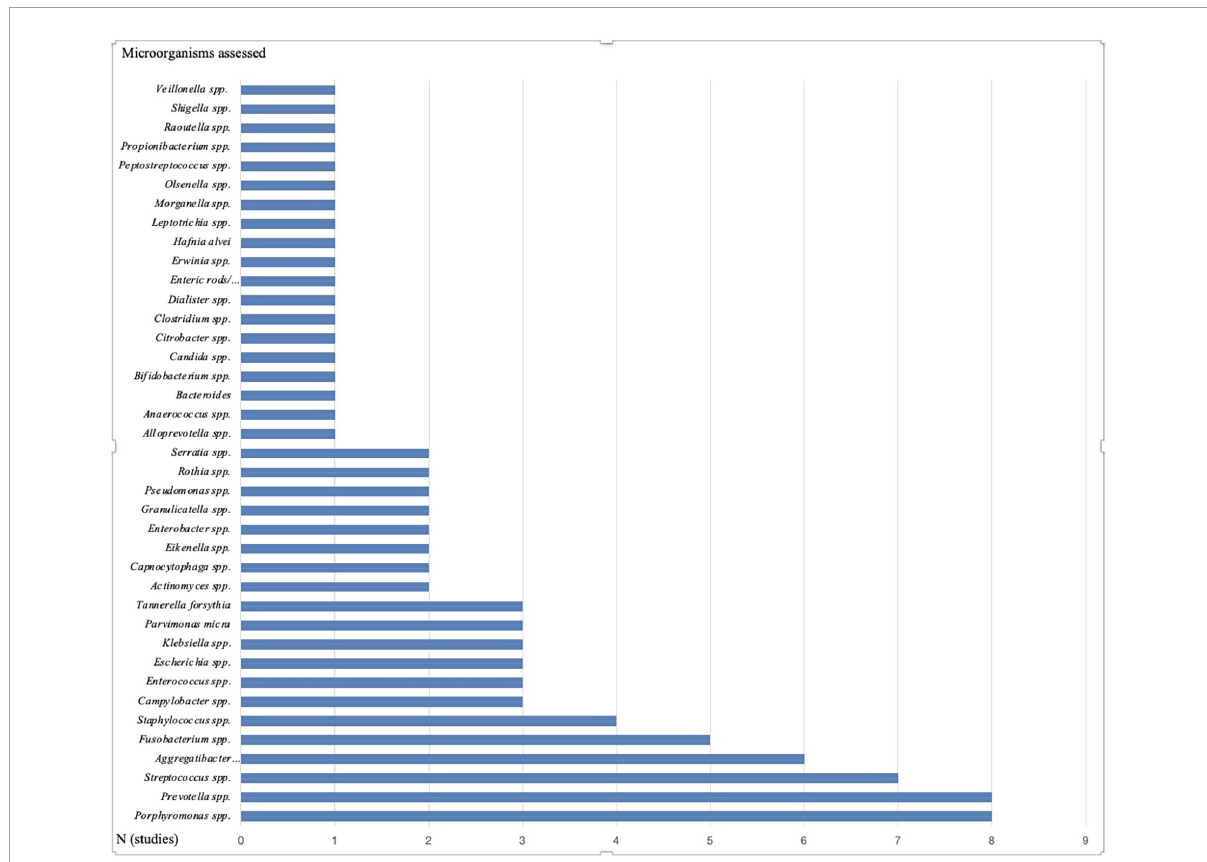
FIGURE2 Microorganisms cited in the included studies. This figure shows the number of studies that evaluated each of the microorganisms.